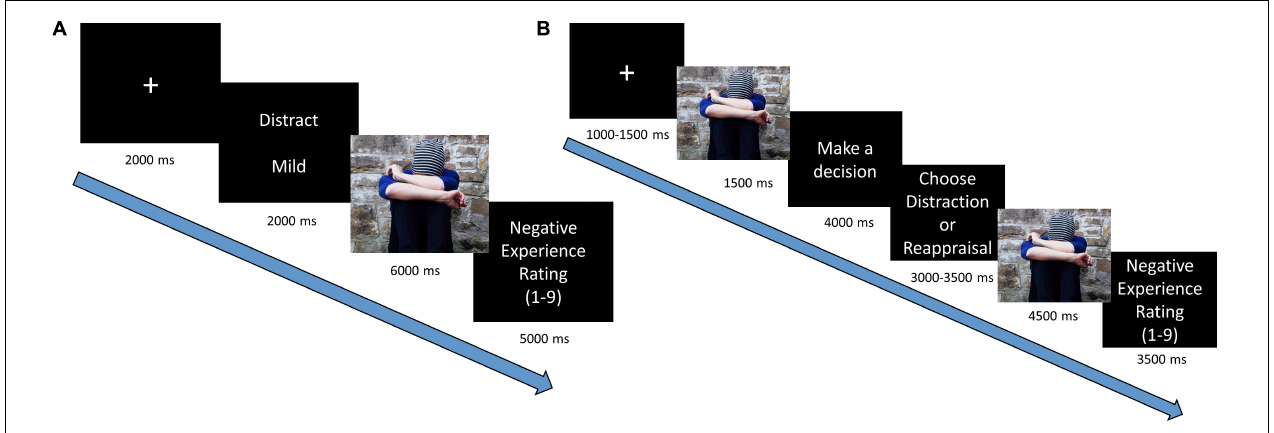
FIGURE 1 | Trial sequence in emotion regulation paradigms: (A) neural implementation task and (B) behavioral regulatory selection task.